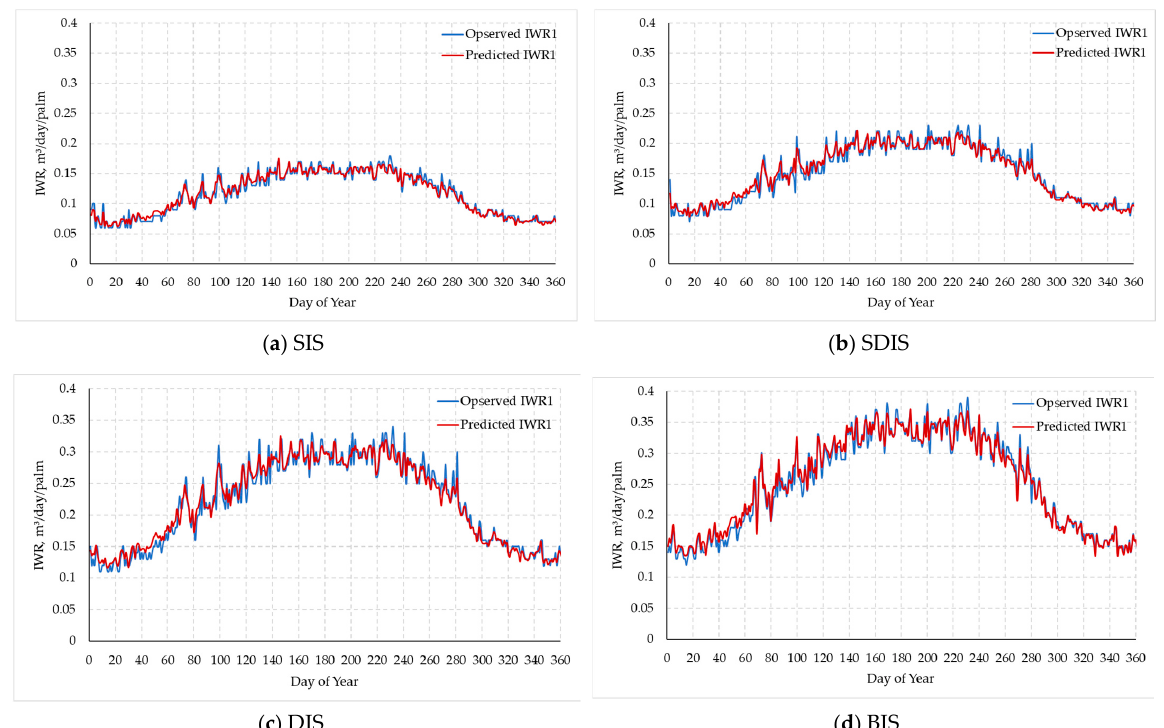
Figure 10. Observed vs. predicted values of irrigation water requirements (IWR1) for optimum water use efficiency under ( a ) subsurface irrigation system, ( b ) subsurface drip irrigation system, ( c ) drip irrigation system, and ( d ) bubbler irrigation system.